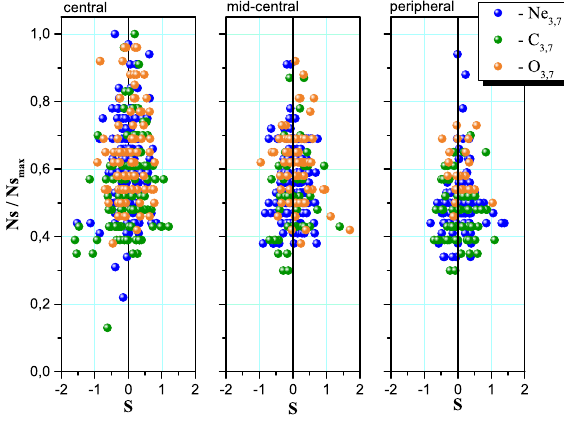
Figure 5. E-by-E accuracy (S) analysis for (C, O, Ne) + (C / N / O)